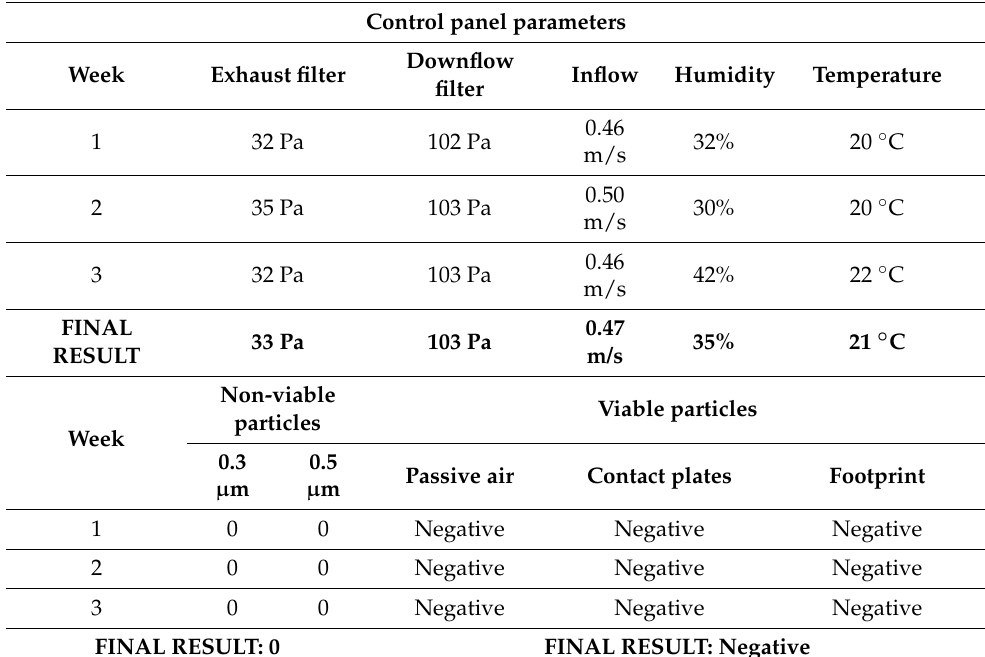
Table 4. Cont . FINAL RESULT: Mean: 0.38 m/s. Laminar flow